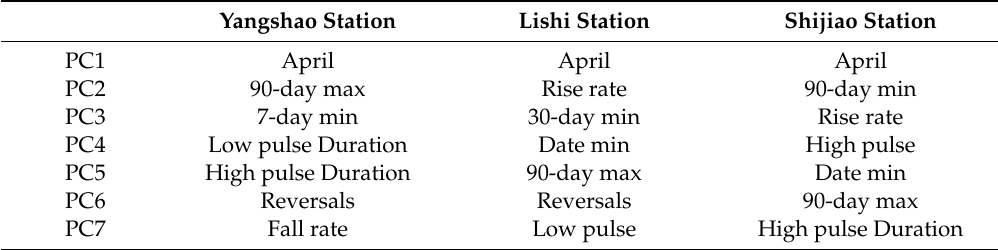
Table 4. Selection of ecologically relevant hydrological indicators (ERHIs) by the principle component analysis